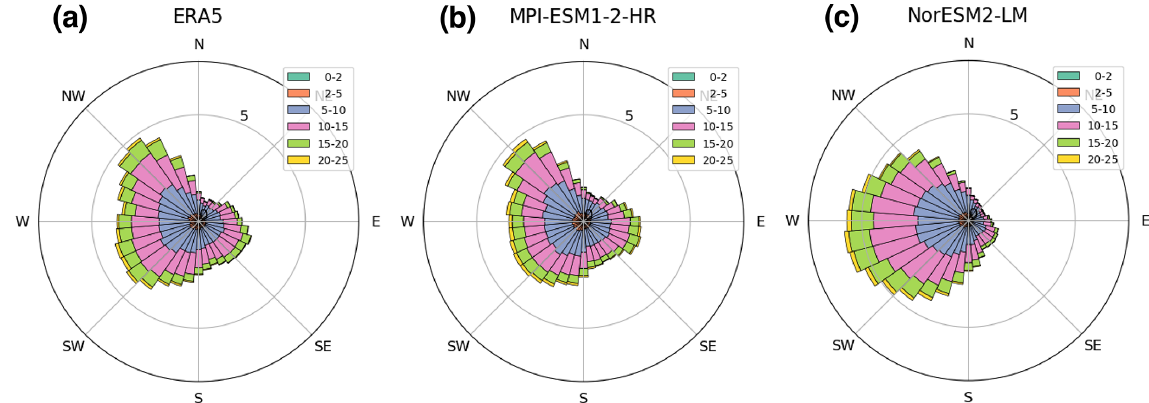
Figure 4. Wind roses of the wind climatology at 100ma.g.l. in the (a) ERA5 reanalysis and simulated by the (b) MPI-ESM1-2-HR and (c) NorESM2-LM CMIP6 models during the historical period (1980–2014) at the Energy Island location. Wind speed bins are in metres per second.